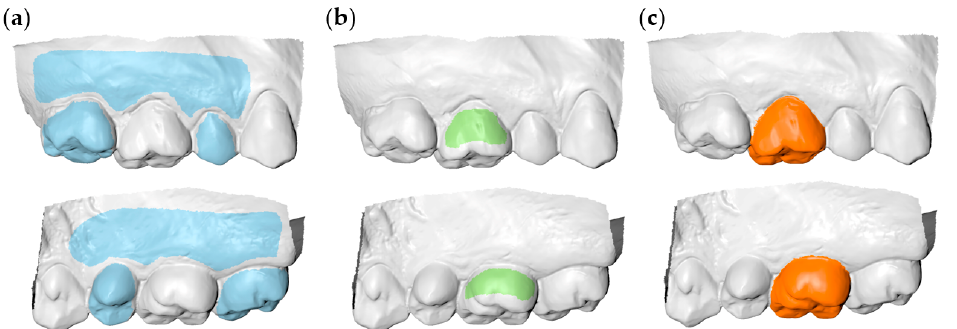
Figure 1. Superimposition reference areas for tooth wear assessment at a maxillary first permanent molar. ( a ) Gold standard area (GS, blue). ( b ) Partial crown area (PC, green). ( c ) Complete crown area (CC, orange). Buccal aspects are shown at the upper row and palatal aspects at the lower